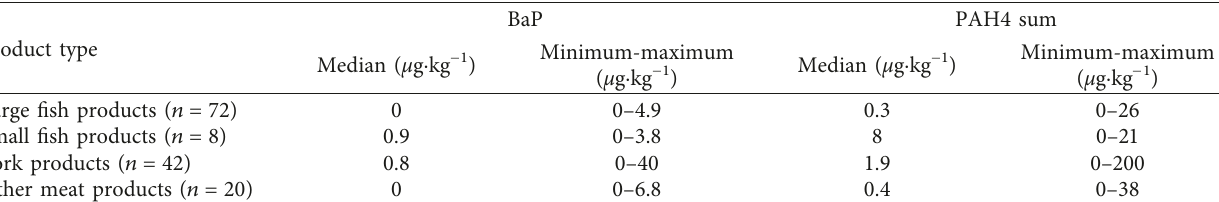
Figure 2: Multiple reaction monitoring chromatogram of benzo[ a ]pyrene at the level of 5.1 µ g Table 3: Median and minimum-maximum concentrations ( µ g other meat